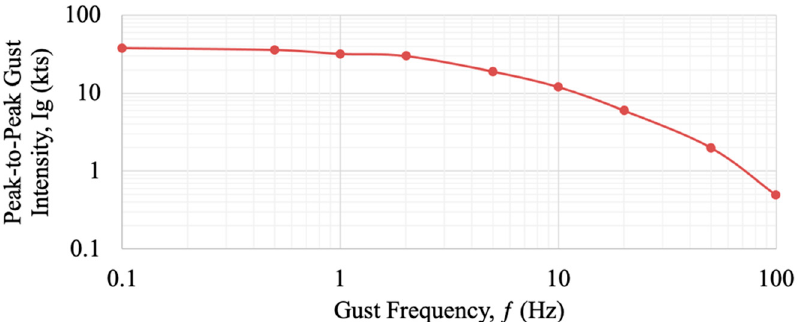
Figure 19. Urban gust field survey of power spectral density, 50% of the far-field day.